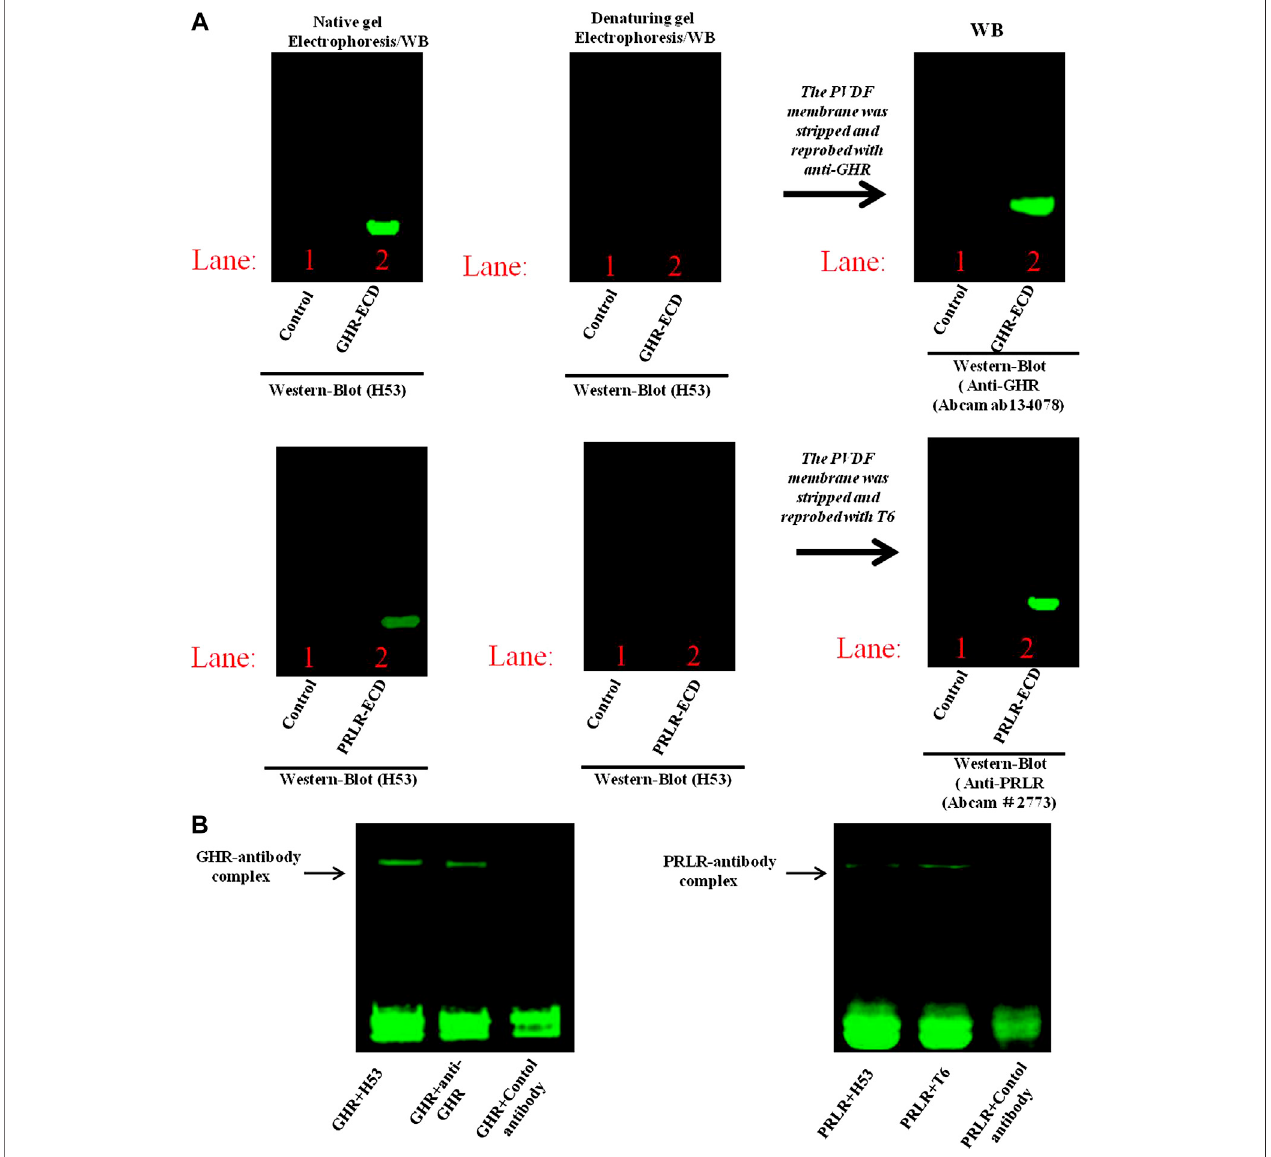
FIGURE 4 | (A) Analysis of epitope recognized by H53 on GHR-ECD or PRLR-ECD. Denatured and non-denatured PRLR-ECD or GHR-ECD were subjected to SDS-PAGEandtransferredtoPVDFmembrane.Afterwashingandblocking,themembraneswereincubatedwithH53,andincubatedwithAlexa-488-labeledgoatanti- mouse for 1 h. After washing, the membranes were analyzed using the Bio-Rad fl uorescence detection system. (B) Detection of direct interaction between H53 and PRLR-ECD/GHR-ECD by native gel electrophoresis. BIO-Rad ChemiDoc XRS Gel Imaging System was used to detect the signal.